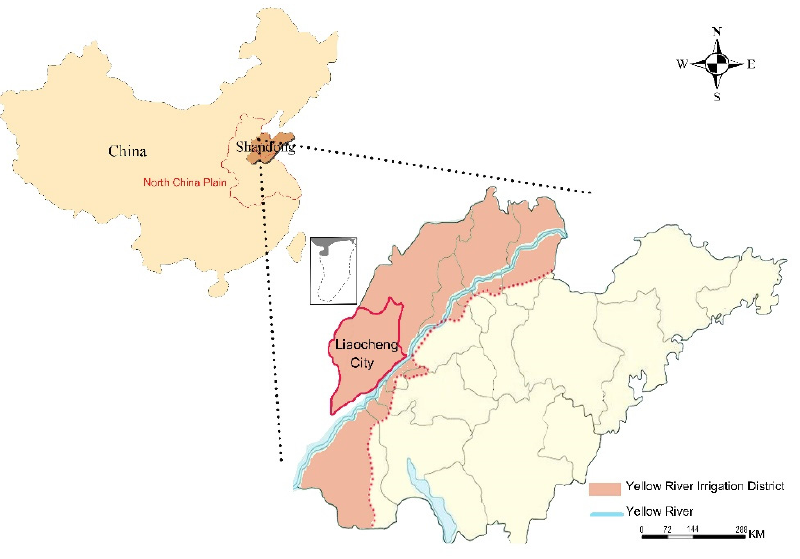
Figure 2. Yellow River Irrigation District of Shandong Province.